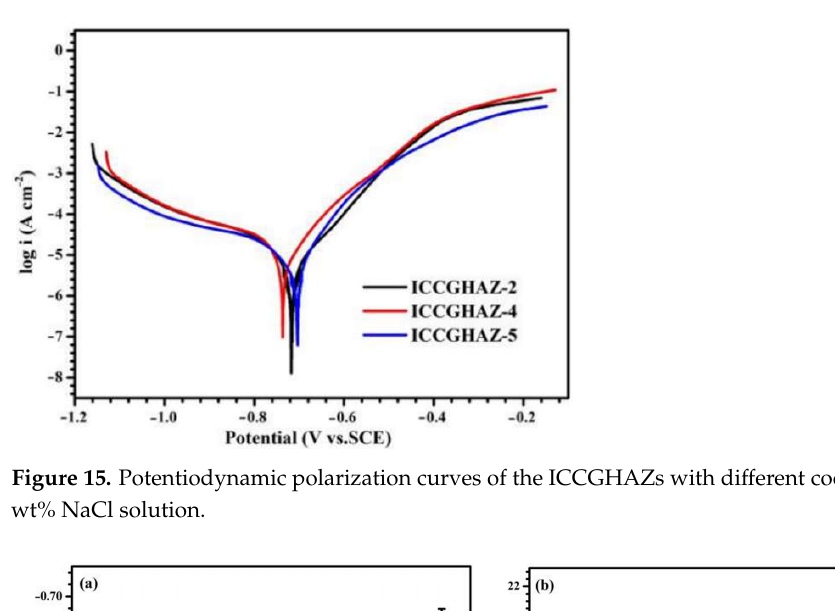
Figure 15. Potentiodynamic polarization curves of the ICCGHAZs with different cooling rates in 3.5 wt% NaCl solution.